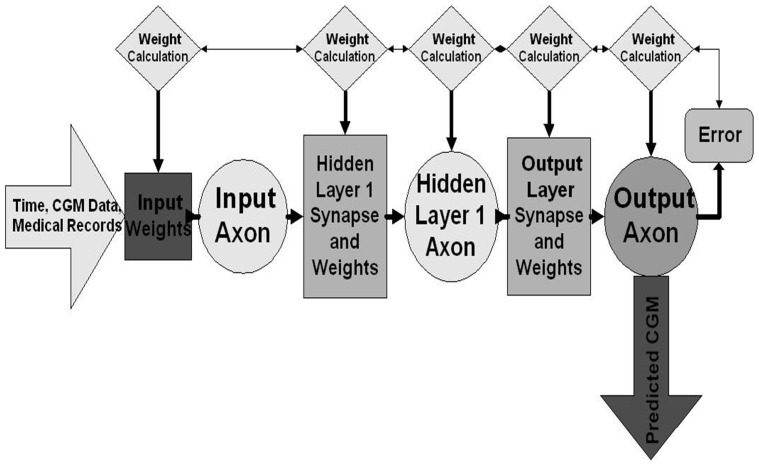
Neural network model design.The feed-forward neural network design implemented for real-time prediction of glucose. Error (mean squared error) is calculated between neural network output and desired response (actual continuous glucose monitoring values). This error is back propagated to each layer in the neural network architecture and a gradient descent with momentum algorithm is implemented to determine optimal weight values to minimize model error.